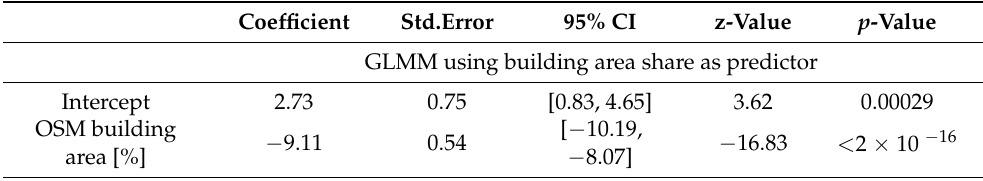
Table 6. Fixed and random effects for the logistic GLMM regression model for the identification of factors influencing the correctness of the classification for “incomplete” tasks. The coefficients belong to two single-predictor models. Coefficients, confidence intervals (CI) and standard errors are reported at the link